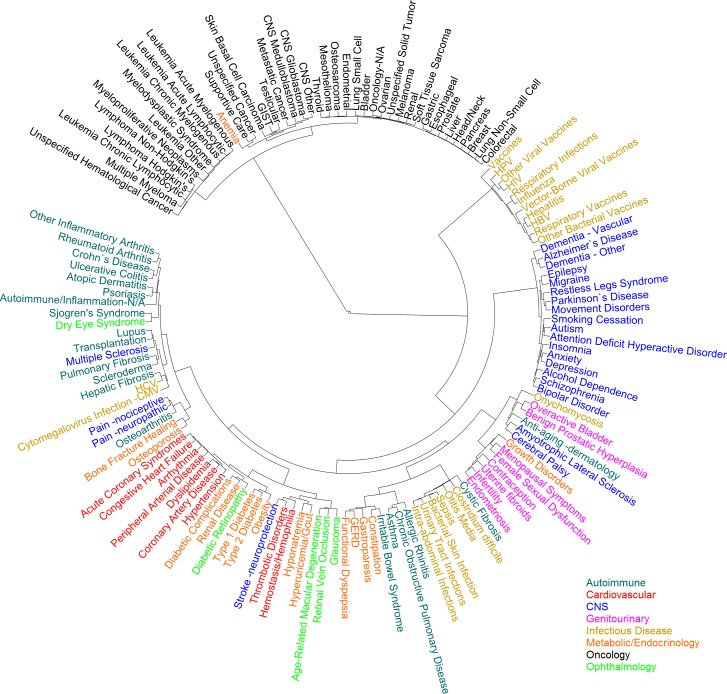
Drug-centric hierarchical clustering of diseases.One hundred forty-one diseases from the Trial dataset were clustered using a distance metric based on the drugs adopted by each disease. The Trial manually-created classification included the categories: autoimmune/inflammation (blue-green), cardiovascular (red), CNS (blue), genitourinary (pink), infectious disease (gold), metabolic/endocrinology (orange), oncology (black), ophthalmology (green).